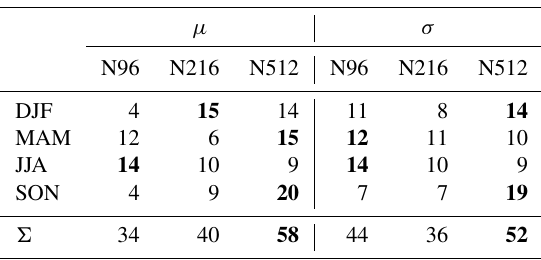
Table 3. Number of basins with smallest bias in µ and σ . For ex- ample, the number 4 for µ in DJF at N96 resolution means that for 4 out of all 33 basins the bias in µ of the N96 model is smaller than that of both the N216 and N512 models. Numbers in bold indicate the resolution with the largest